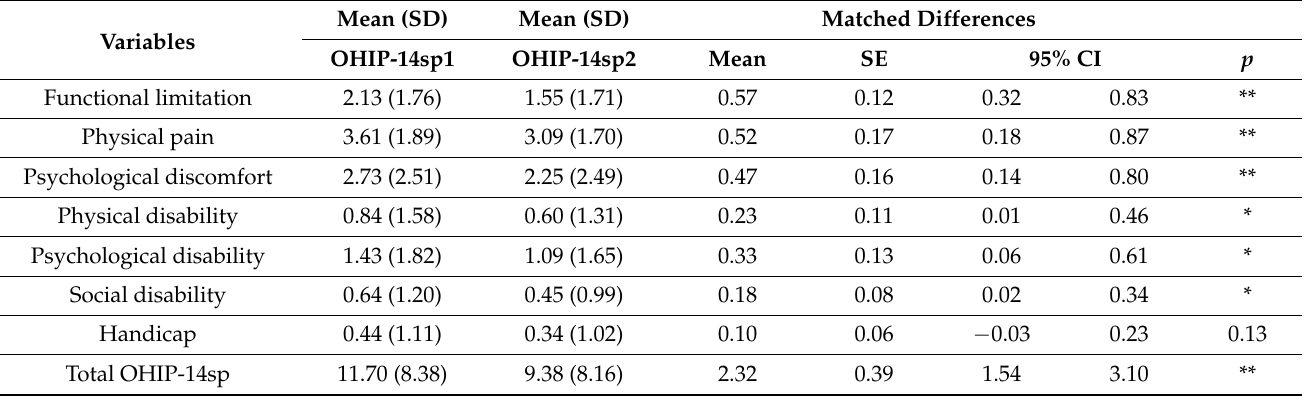
Table 1. Mean and standard deviation with respect to the 7 dimensions of OHIP-14sp pre- (OHIP- 14sp1) and post-treatment (OHIP-14sp2) and the total score.